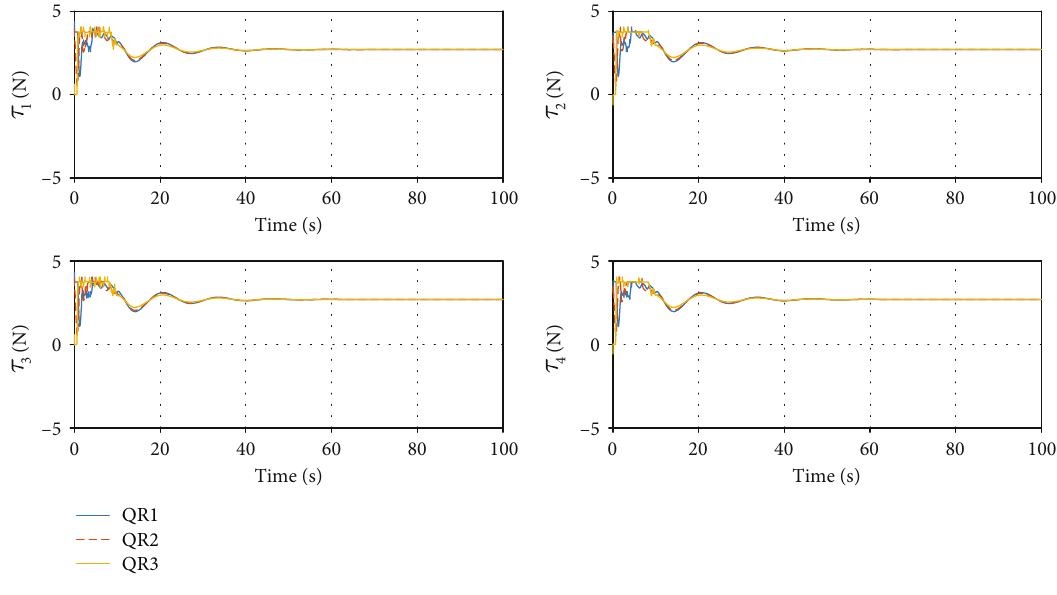
Figure 10: Torque